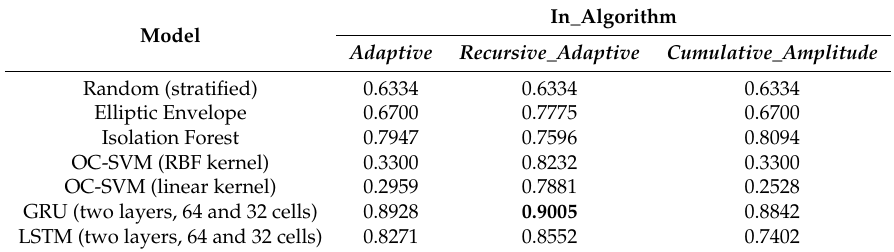
Figure 15. The ROC curve for algorithm cumulative_amplitude ( in _ algorithm = cumulative_amplitude , in _ grid = 32, GRU (two layers, 64 and 32 cells) + Dense). Table 2. Testing accuracy (20% of dataset). All models were run with in _ grid = 32 and look _ back = 256, using single input channel (U RES ), NNs were trained for 7 epochs. The best result is marked in bold.